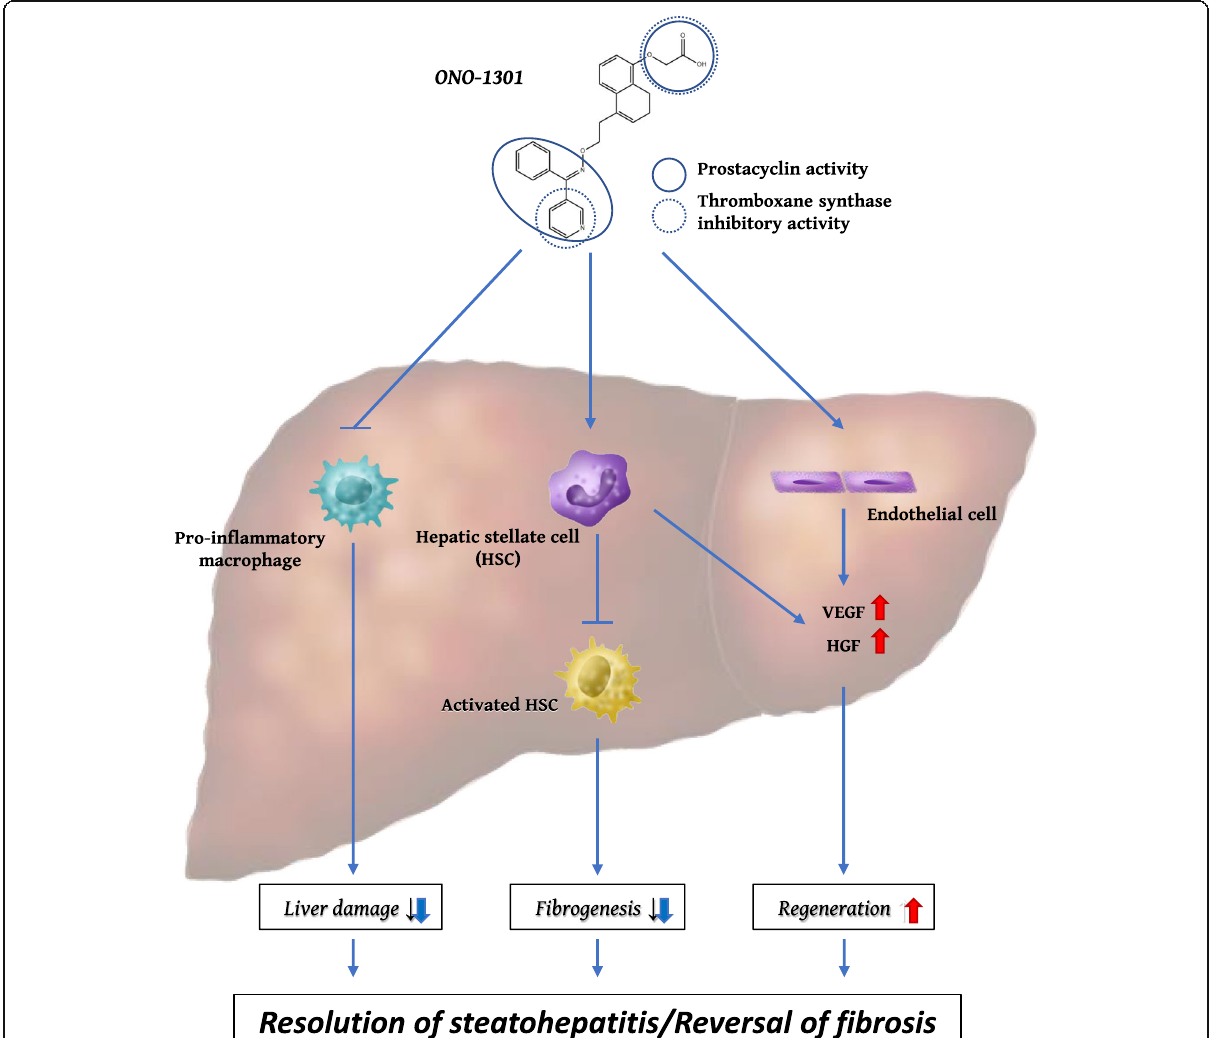
Fig. 7 Schematic representation of the results of the current